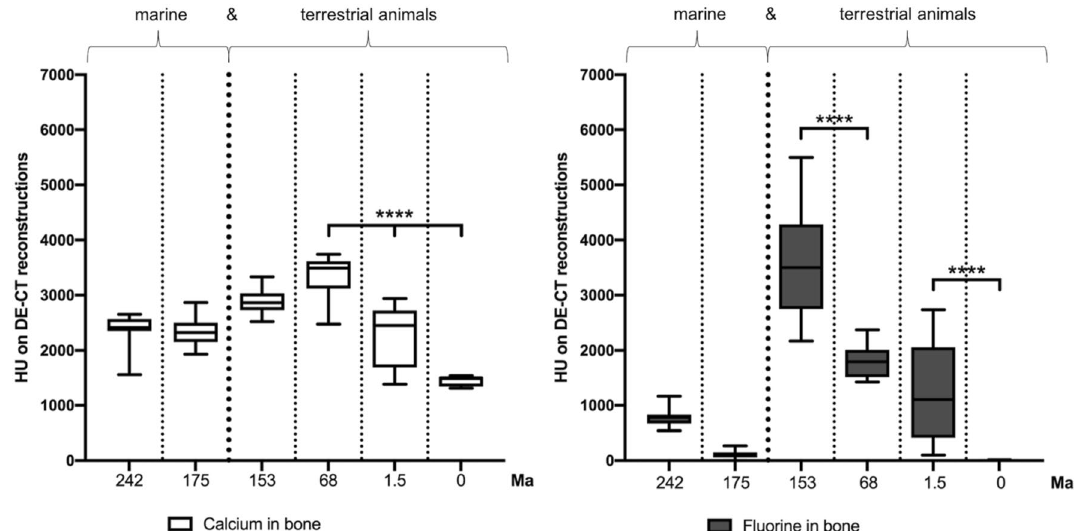
Figure 5. Correlation of geological age with calcium and fluorine contents in bone. In the horizontal, the objects are divided into marine and terrestrial animals and listed in order of their geological time periods. Quantitative assessment of detected calcium and fluorine in DECT reconstructions in bone relative to their age. Significant differences are indicated by * between the fluorine content in bone relative to the specimen age (****p <